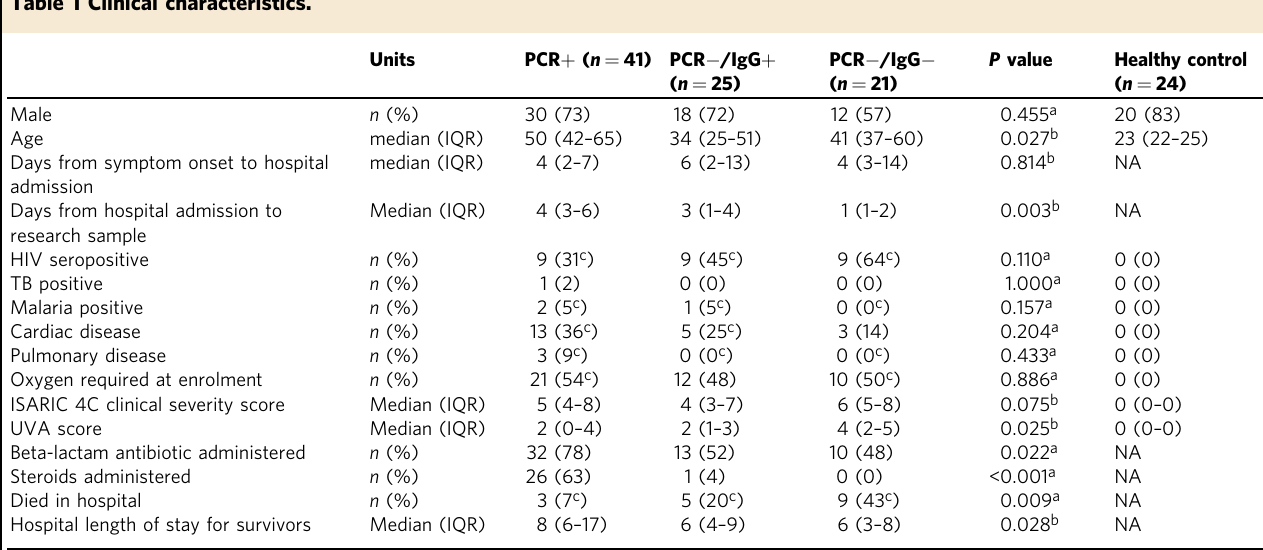
Table 1 Clinical